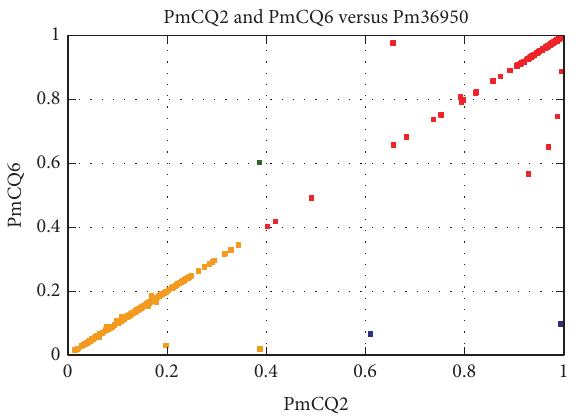
Figure 4: The distribution diagram of BLAST score ratio (BSR) between PmCQ2, PmCQ6, and Pm36950. Pm36950 was obtained from NCBI and used as a reference genome sequence. The color coding is as follows: yellow: PmCQ2 < 0.4 and PmCQ6 < 0.4; red: PmCQ2 ≥ 0.4 and PmCQ6 ≥ 0.4; green: PmCQ2 < 0.4 and PmCQ6 ≥